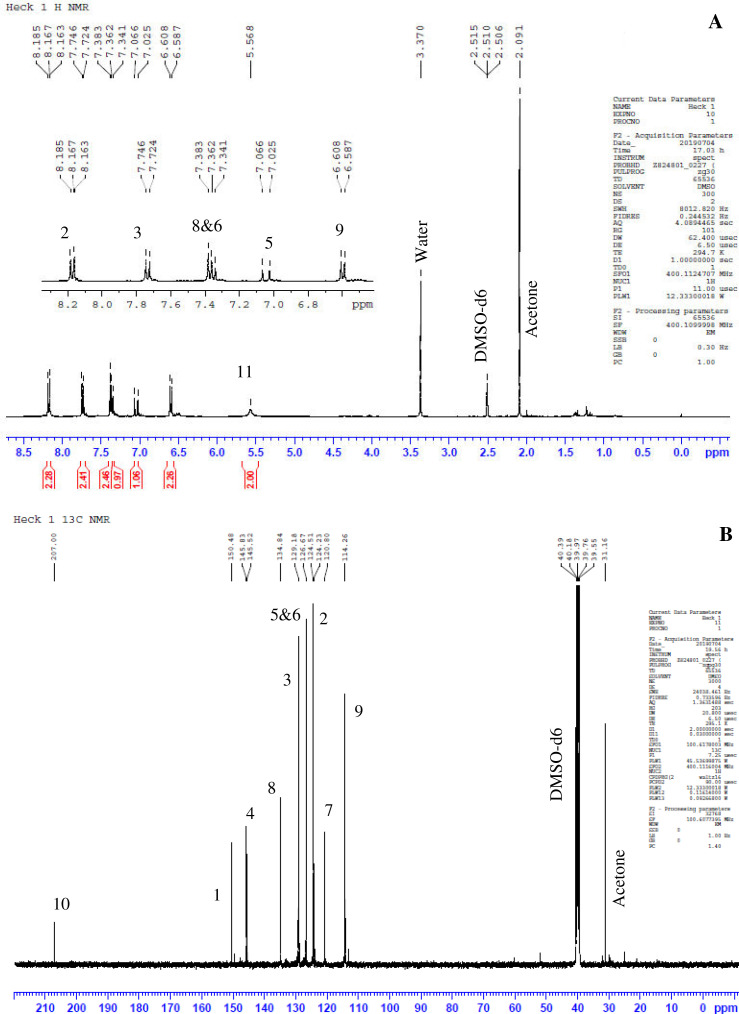
(A) 1H and (B) 13C NMR of Heck 1.